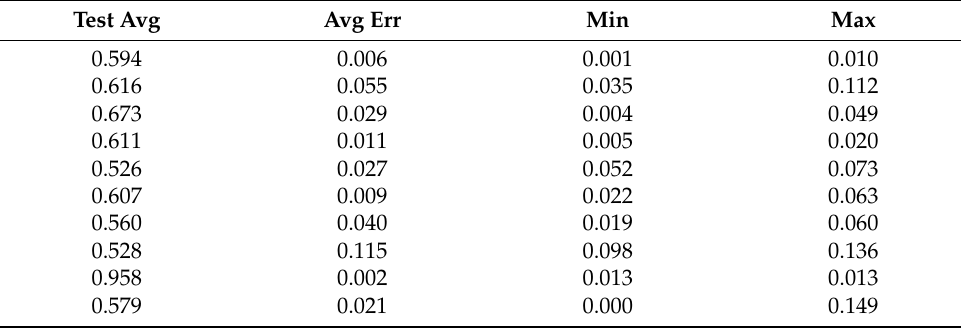
Table A115. Set 2, trials 21–30 data (actual PR